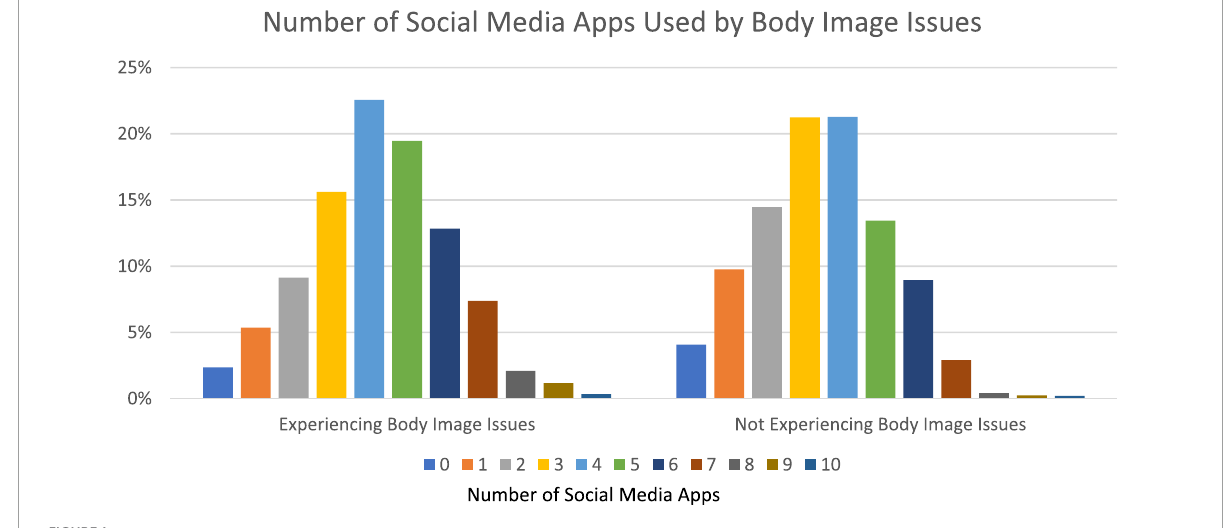
FIGURE1 Distribution of the number of reported social media (SM) platforms used by respondents’ report of experiencing body image issues (BII).